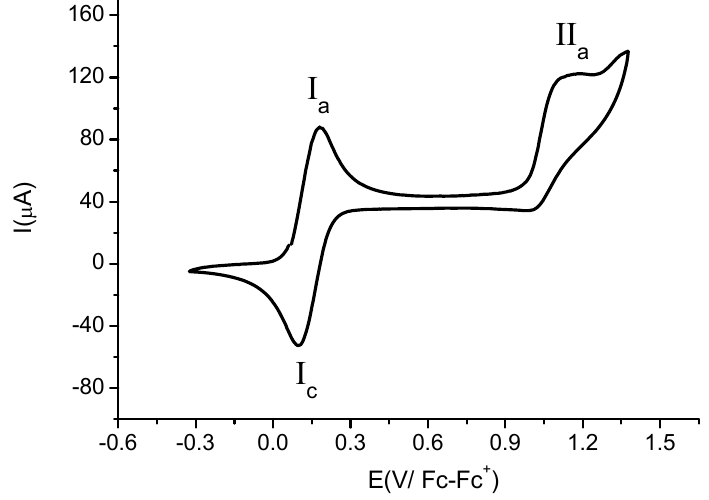
Figure 5. Cyclic voltammogram of compound 4b in the presence of 0.1 M TBABF MeCN. The scan rate 0.10 V·s − 1 . The working electrode used was